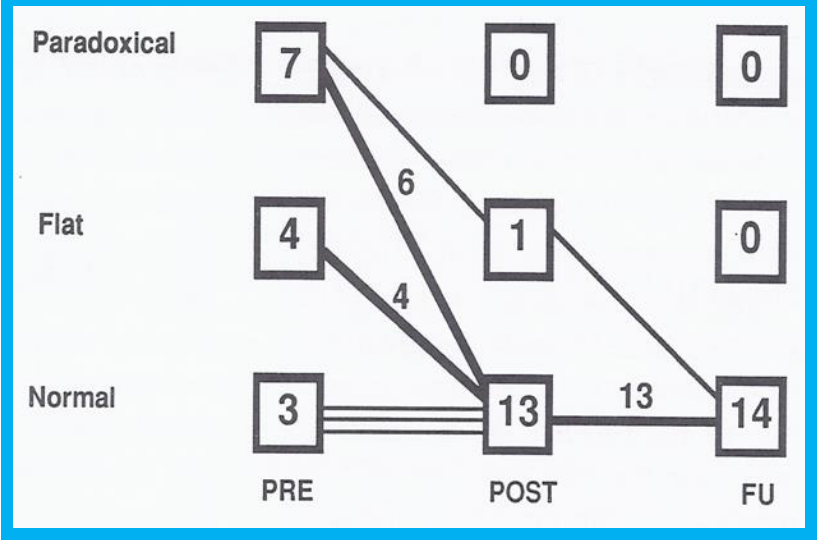
Figure 9. Graph illustrating the effect of transcatheter closure of atrial septal defect (ASD) with buttoned device on the ventricular septal motion: Prior to ASD closure (PRE), the ventricular septal motion is either paradoxical or flat in the majority of patients. Immediately after ASD occlusion (POST), the ventricular septal motion is normal in all but one patient, and at follow-up (FU), the ventricular septal motion returned to normal in all patients. Reproduced from Rao P.S., et al. [9].